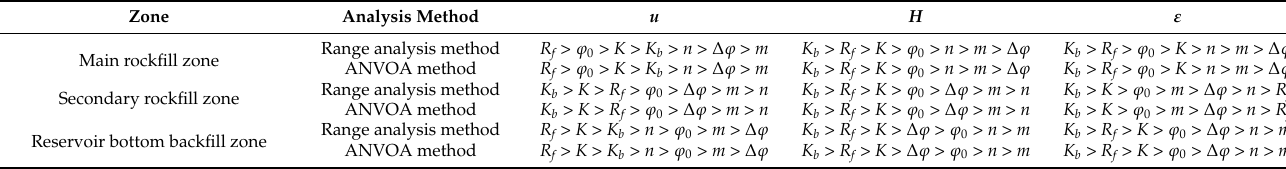
Table 14. Sensitivity results of range analysis and